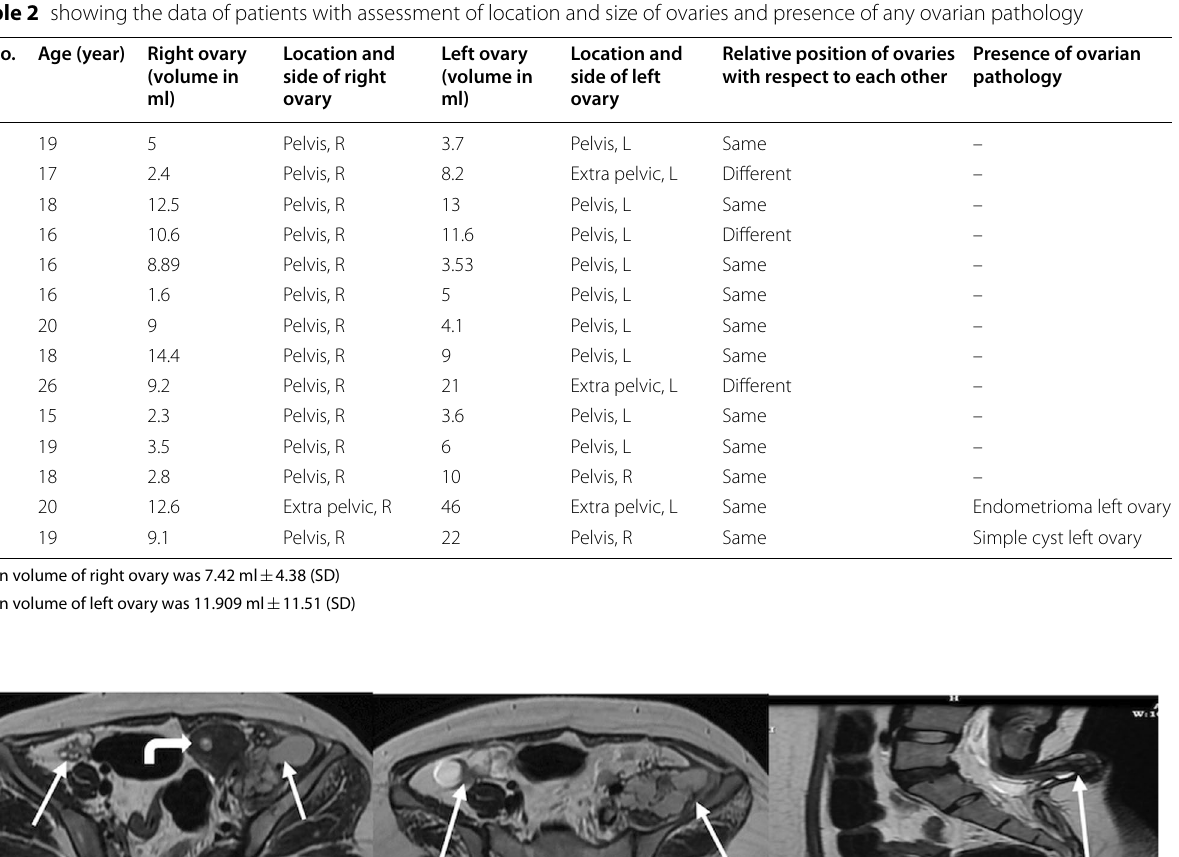
Table 2 showing the data of patients with assessment of location and size of ovaries and presence of any ovarian pathology S. No. Age (year) Right ovary (volume in